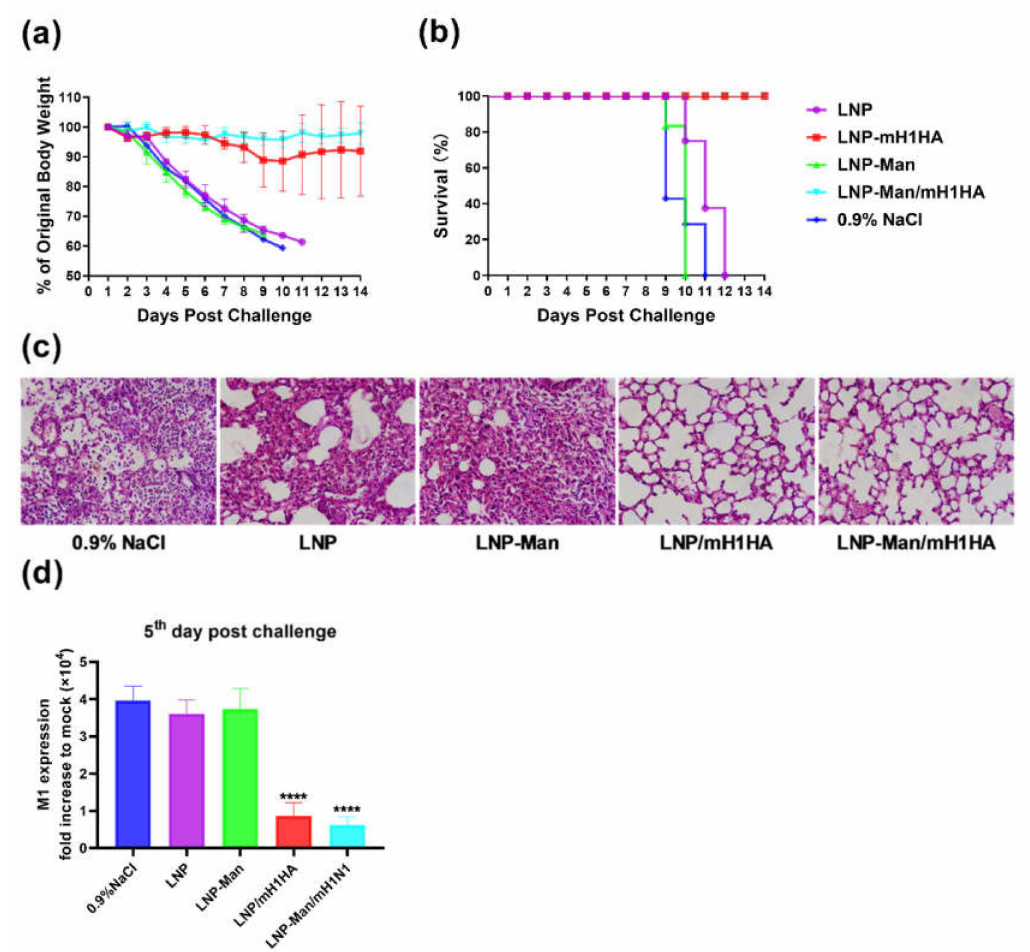
Figure 6. Evaluation of the protective e ff ects after the challenge. ( a ) Body weight changes and ( b ) Kaplan–Meier survival curves of H1N1-infected C57BL / 6 mice ( n = 6) treated with vaccines or vehicles by intranasal administration. Two weeks after the boost immunization, mice were infected with 10 × LD 50 A / Jilin / JYT-01 / 2018(H1N1) influenza virus. Lungs were collected at 5th day post-infection. ( c ) Representative images of lung pathology in hematoxylin-and-eosin-stained sections from H1N1-infected C57BL / 6 mice ( n = 3). ( d ) Viral loads expressed as the fold change compared to noninfected lungs. Data are shown as means ± SDs and were analyzed by one-way ANOVA ( n = 3, **** p < 0.0001, compared to 0.9% NaCl, LNP, and LNP-Man